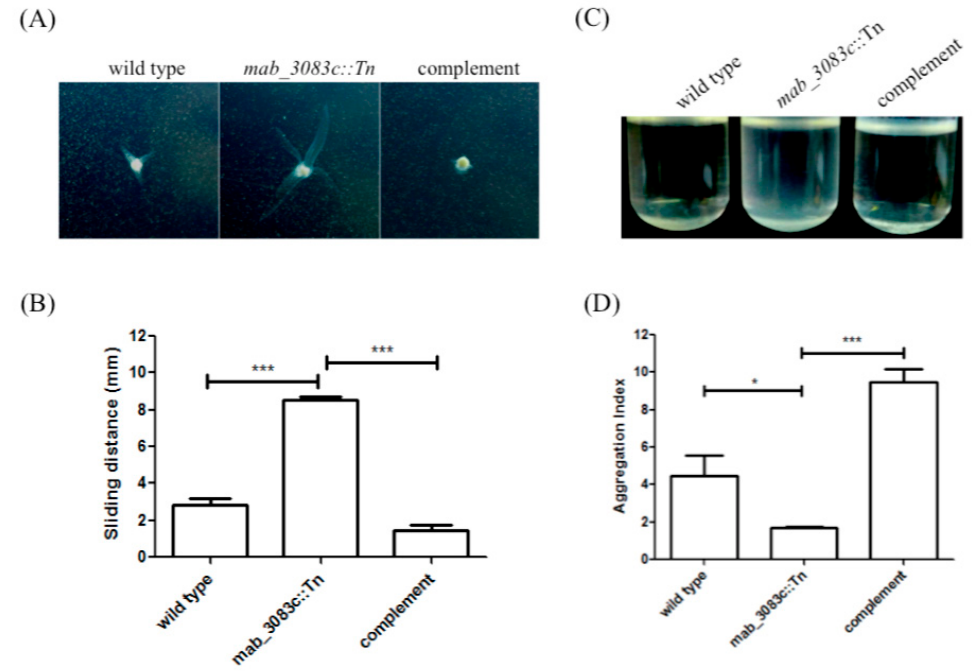
Figure 4. Sliding motility and aggregation capability of M. abscessus wild type, mab_3083c::Tn, and complemented strains. ( A ) Sliding ability of the tested strains. ( B ) Quantification of sliding ability. The sliding distance was measured in mm and plotted. ( C ) Aggregation capability of the tested strains. ( D ) The aggregation index of these three strains. Data were analyzed with one-way ANOVA and Tukey’s multiple comparison. * p < 0.05, *** p < 0.001.